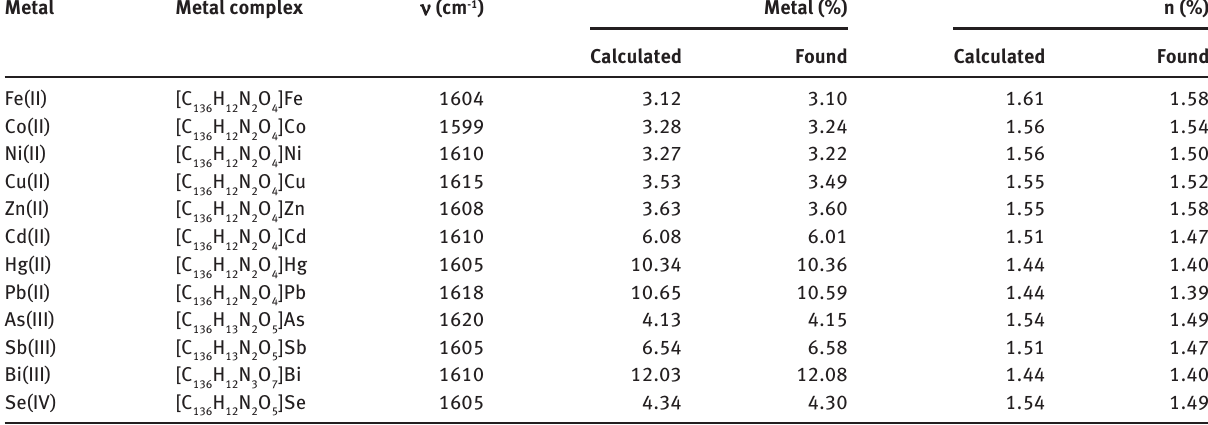
Table 1 Characteristics of metal hydroxamates.